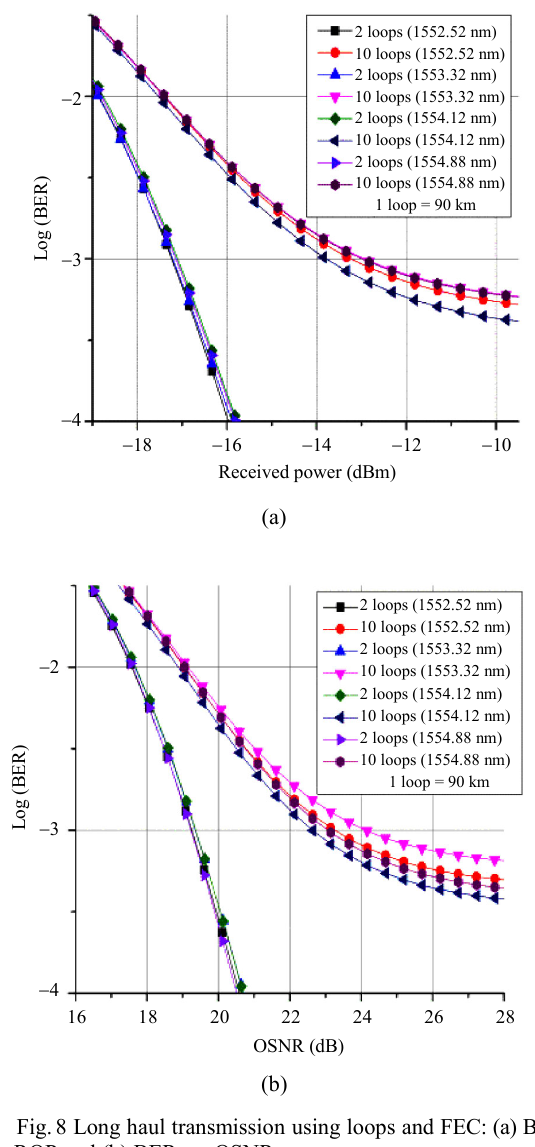
Fig. 8 Long haul transmission using loops and FEC: (a) BER vs. ROP and (b) BER vs.